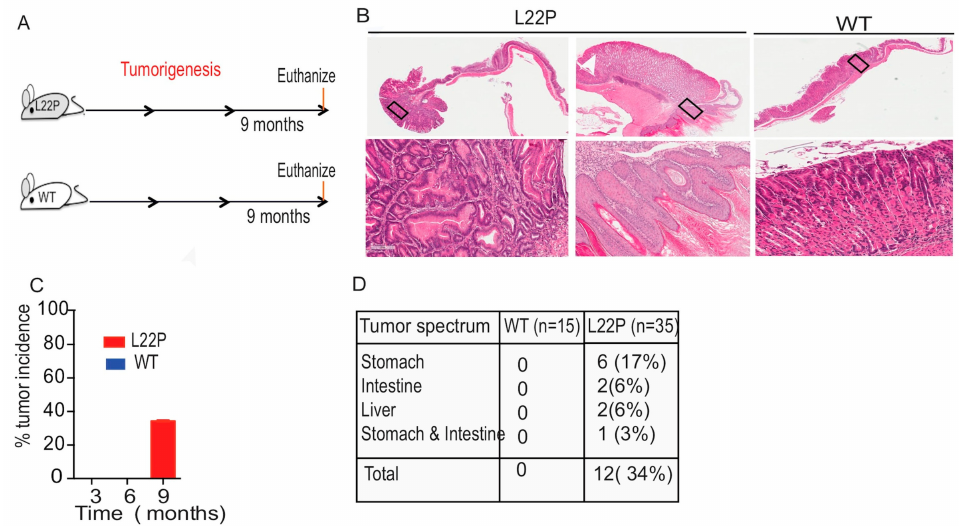
Figure 7. L22P increased tumor incidence and spectrum in mice. ( A ) Schematic representation of the tumorigenesis study’s experimental design ( B ) Representative tumor images wild type (WT) and L22P mice followed up for 9 months. Images of the stomach tissue sections shows 1 × magnification (upper panel) and 10 × magnification (lower panel) were captured using Scanscope (Leica Biosystem, Vista, CA, USA); ( C ) percent of tumor incidence in WT and L22P mice at 3 months (WT ( n = 12); L22P ( n = 13), 6 months (WT ( n = 8); L22P ( n = 18), and 9 months of experiment (WT ( n = 15); L22P ( n = 35); ( D ) Tumor spectrum was observed at 9 months of